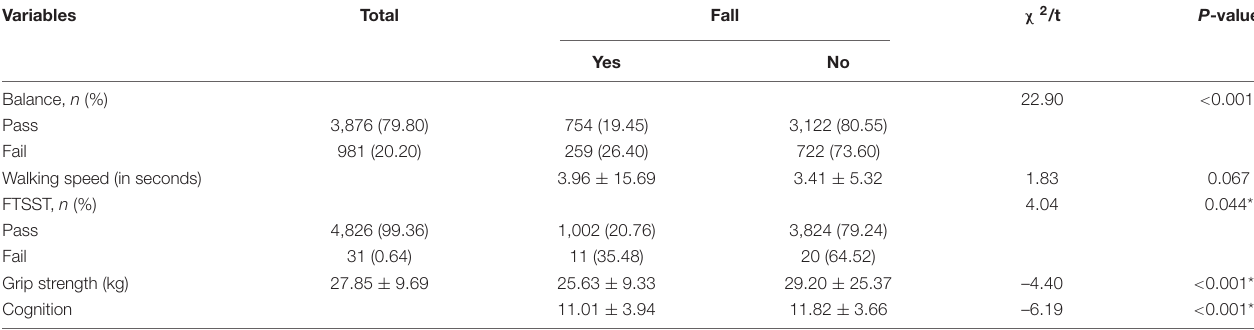
TABLE 2 | Comparison of the five function tests between the falls and no falls group in the full sample ( n = 4,857). Variables Total Fall